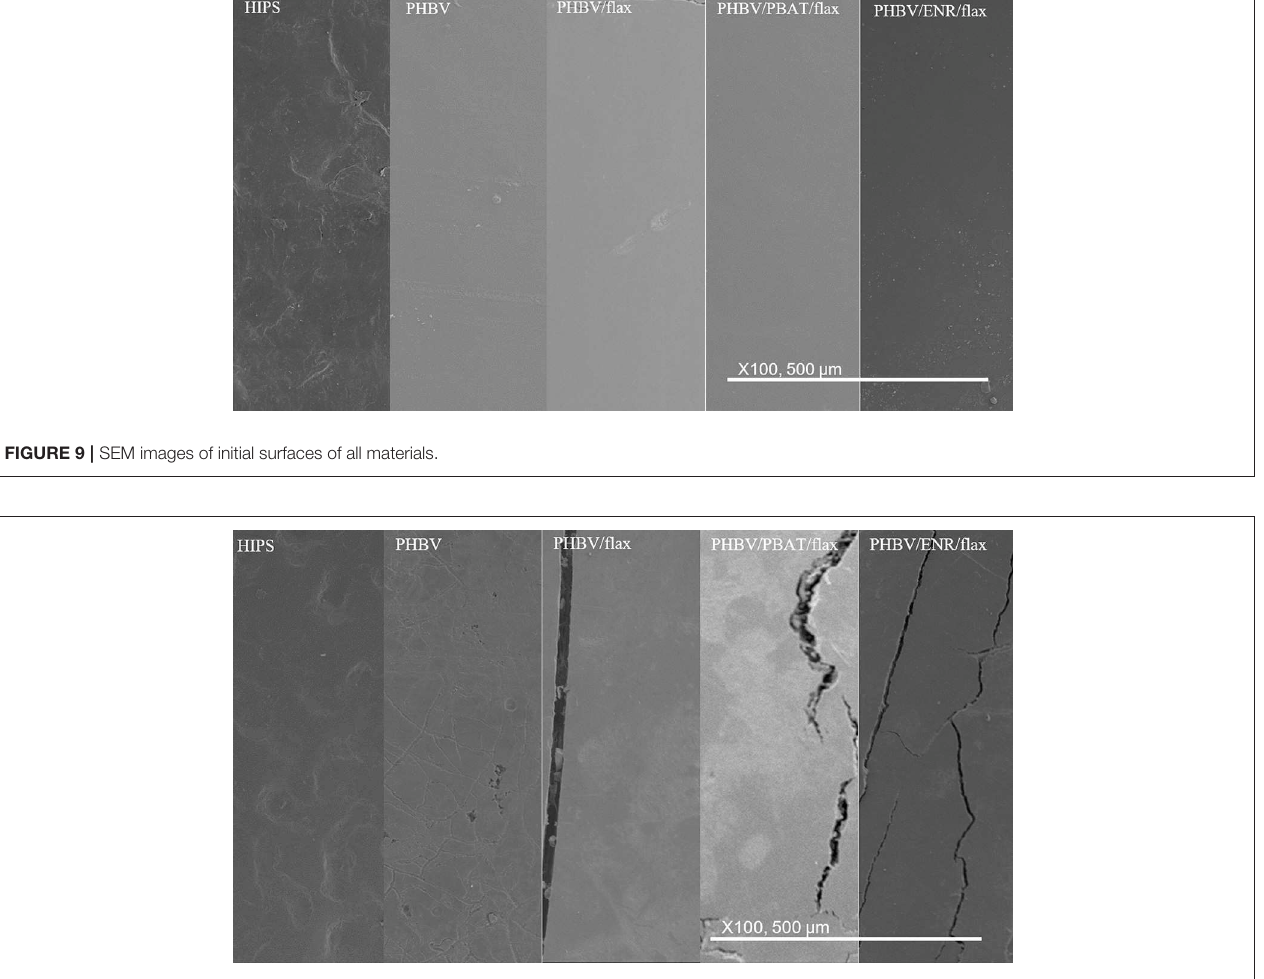
FIGURE 10 | SEM images of surfaces of all materials after 28 days.